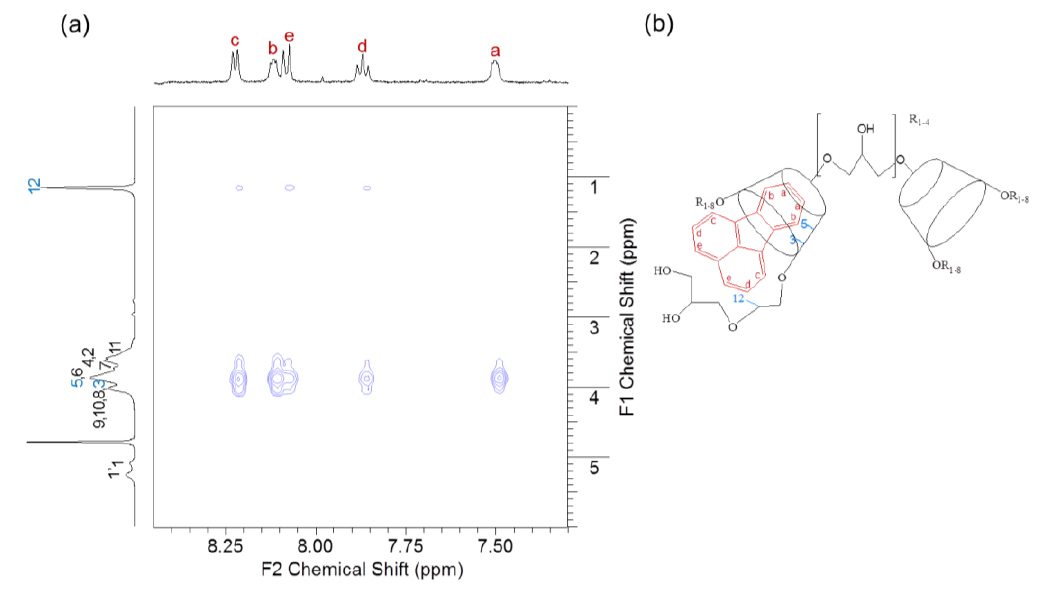
Figure 9. ( a ) NOESY spectrum of FT/HP-β-CD-ol IC in D 2 O solvent with a mixing time of 500 ms; ( b ) Proposed model of FT/HP-β-CD-ol IC.